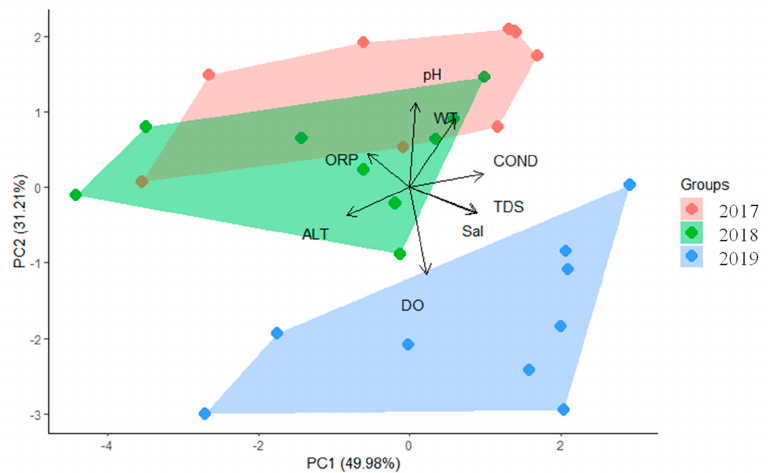
Figure 2. PCA biplot of environmental components based on the euclidean distance for three analyzed periods. Abbreviation: altitude (ALT), conductivity (COND), dissolved oxygen (DO), total dissolved solids (TDS), salinity (Sal), water temperature (WT), hydrogen ion concentration (pH), and oxidation-reduction potential (ORP). Moreover, except for hydrogen ion concentration, dissolved oxygen, and oxida- tion-reduction potential, the remaining environmental factors were not significantly dif- ferent across periods such as water temperature, altitude, total dissolved solids, conduc- tivity, and Salinity (Table 1). Particularly, the 2017 period had higher values of water temperature and hydrogen ion concentration, while the dissolved oxygen concentration was found to be higher in the 2019 sampling time, and the remaining environmental factors had nearly equal values throughout the periods. Information on the correlation between environmental factors for the studied stream can be found in the supplementary of Table S1. Table 1. General statistics of local environmental variables and results of the Kruskal-Wallis test for three periods. “***” denote significant differences at p < 0.05 and p < 0.001, respectively, whereas “ns” denotes non-significant differences. 2017